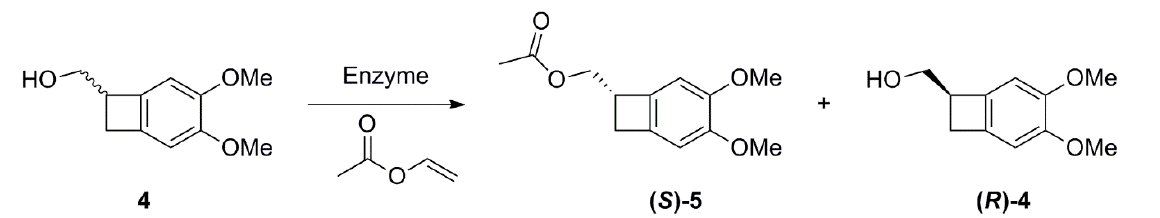
Table 1. Results from screening of enzymes on the acetylation of racemic